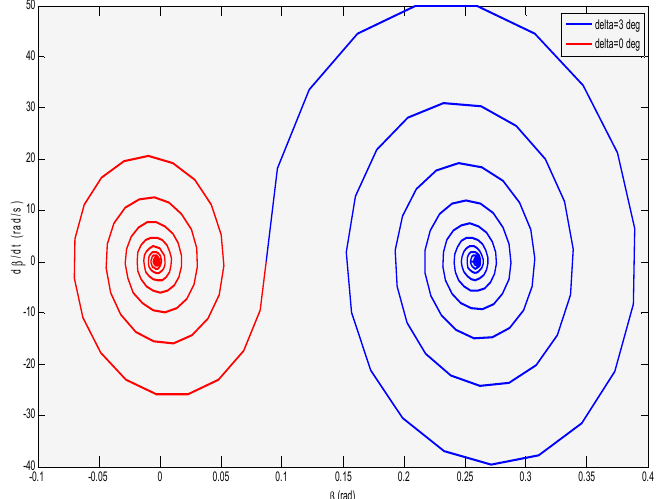
Figure 25. The state space response of beta without freeplay and with 2 ◦ freeplay. (In lower speed of flutter).